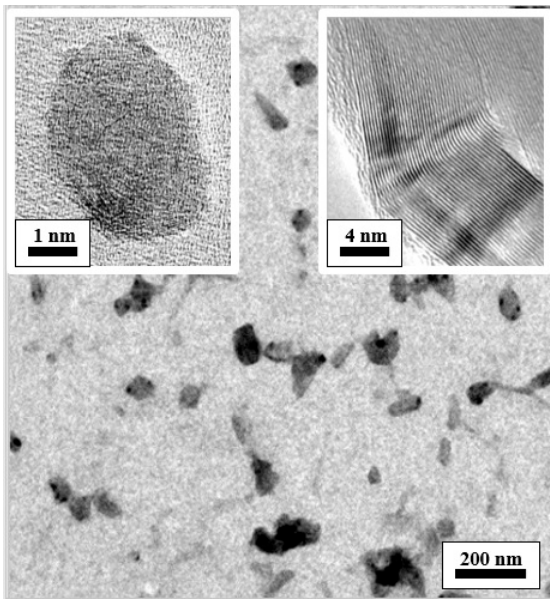
Figure 1. TEM images of carbon nanocapsules (CNCs) dispersed in water.